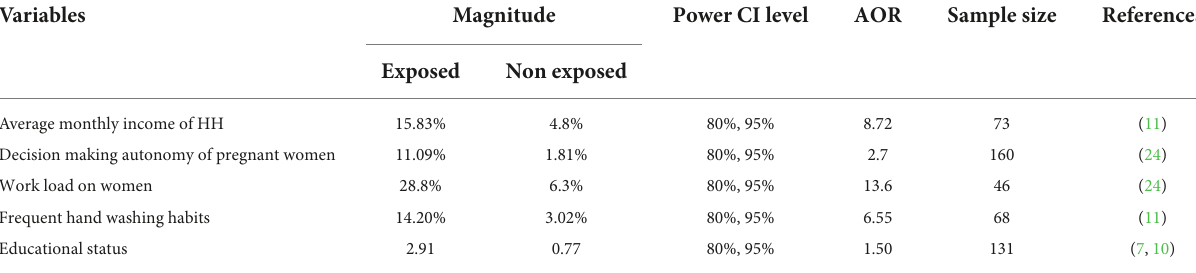
TABLE 1 Sample size calculation for the second specific